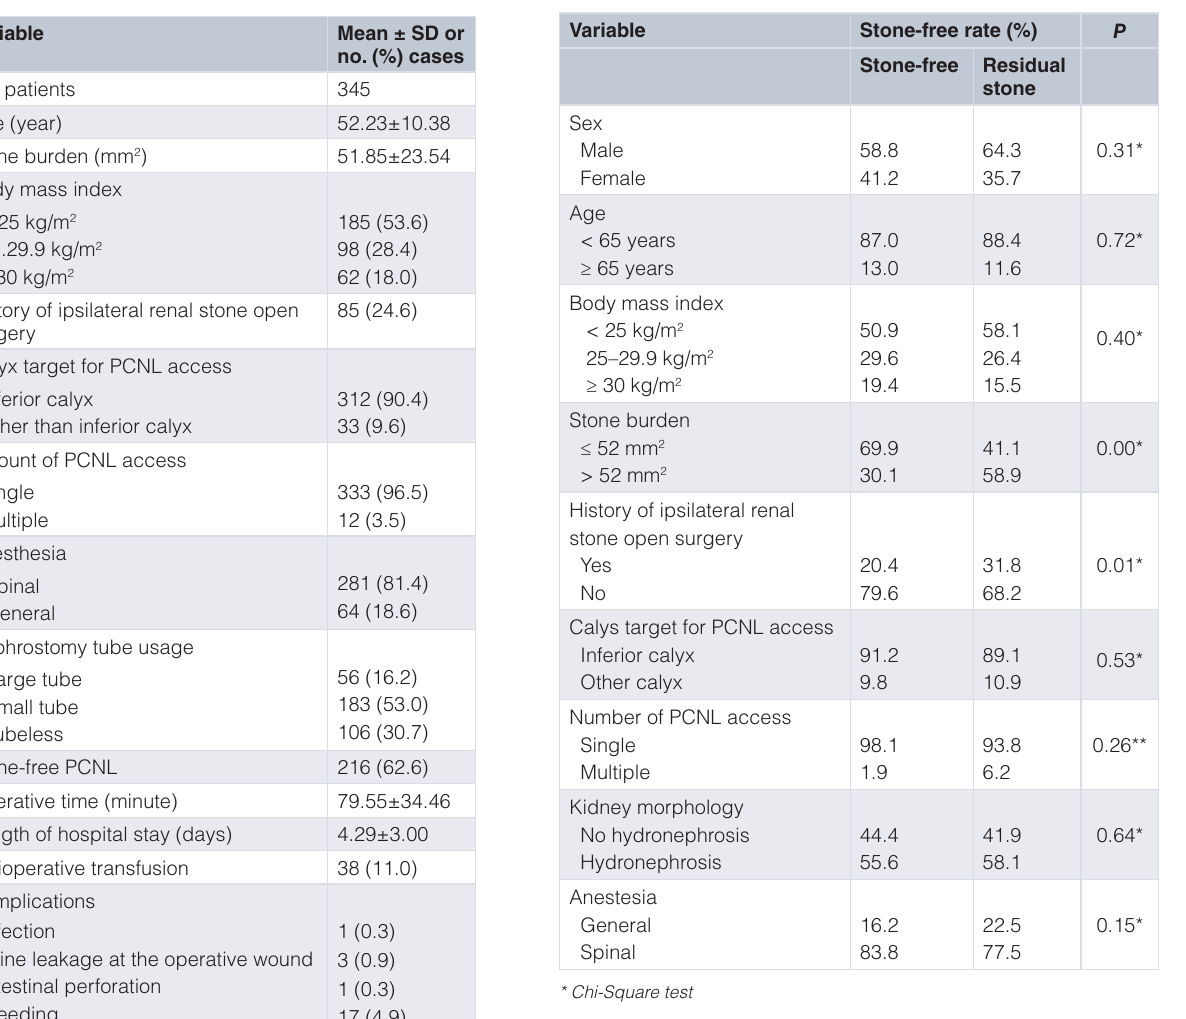
Table 2. Univariate analysis of factors that associated with the stone-free